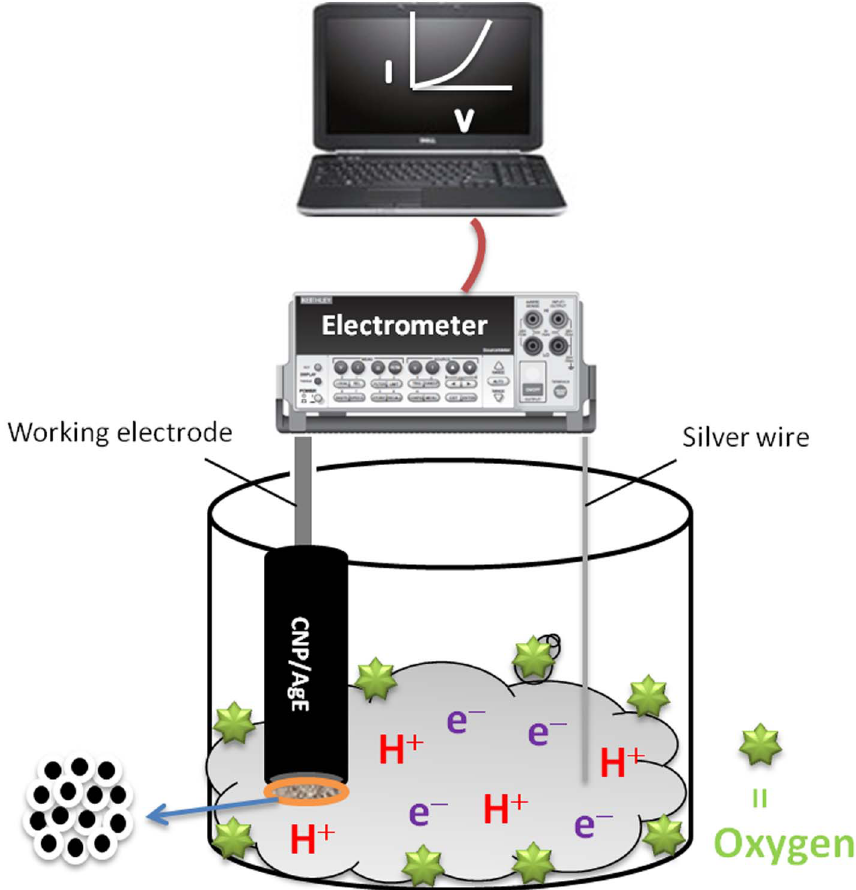
Figure 2. Construction of cell for the detection of phthalimide.